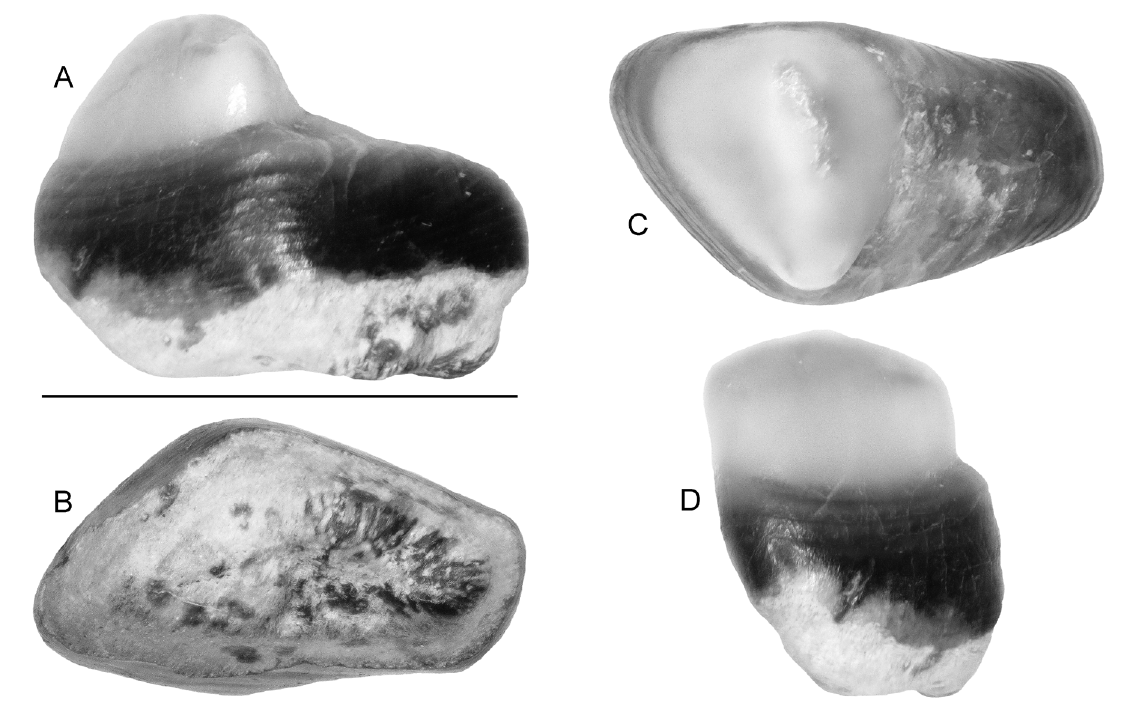
Fig. 67. Balistidae Risso, 1810, tooth. A–D . MSC 2402, Gosport Sand. A . Profile view. B . Basal view. C . Oral view. D . Anterior view. Anterior at left in A–C. Scale bar =